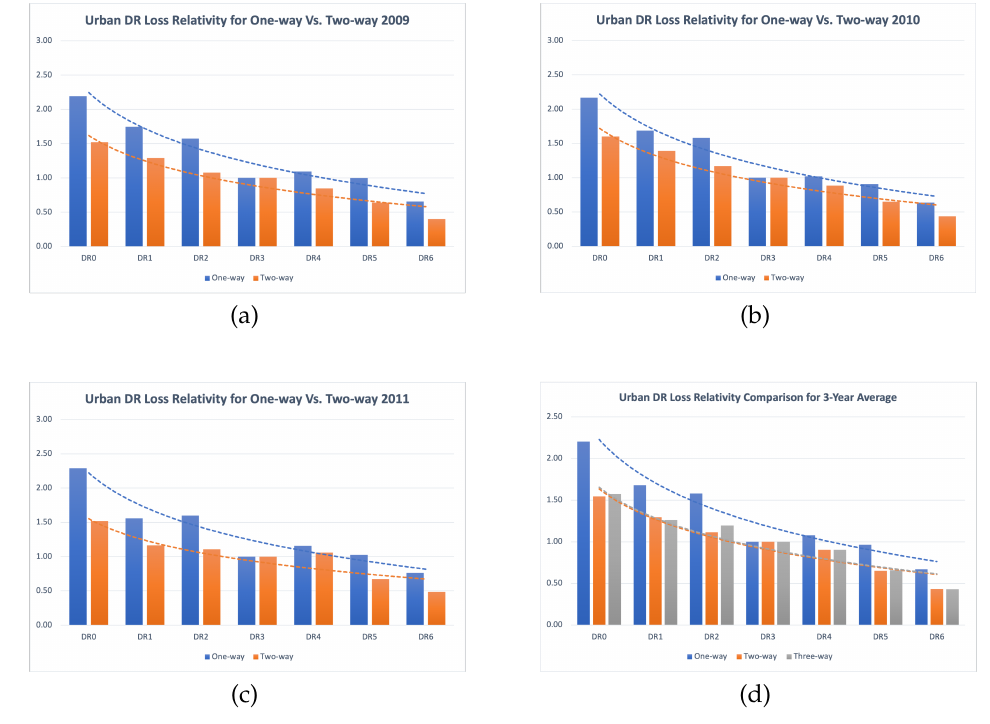
Figure 4. Comparison of DR relativity based on Urban loss data, estimated by different models including one-way, two-way and three-way models. ( a – c ) present the comparison between one-way and two-way analysis, respectively for year 2009, 2010 and 2011. ( d ) shows the comparisons of one way, two-way and three-way for three years average